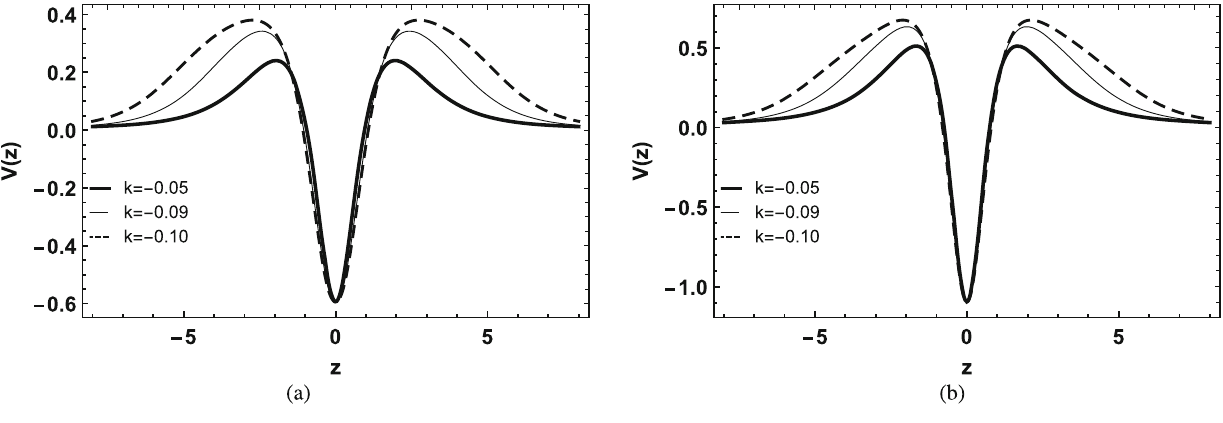
Fig. 3 Effective potential behavior for G 2 (φ) with n = 2, b = 4 and p = λ = 1. a Gauge field. b KR